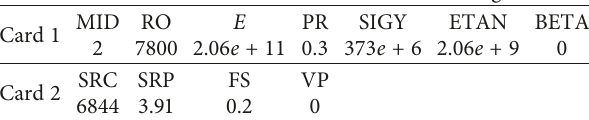
Table 5: ∗ MAT_003 constitutive model of reinforcing steel